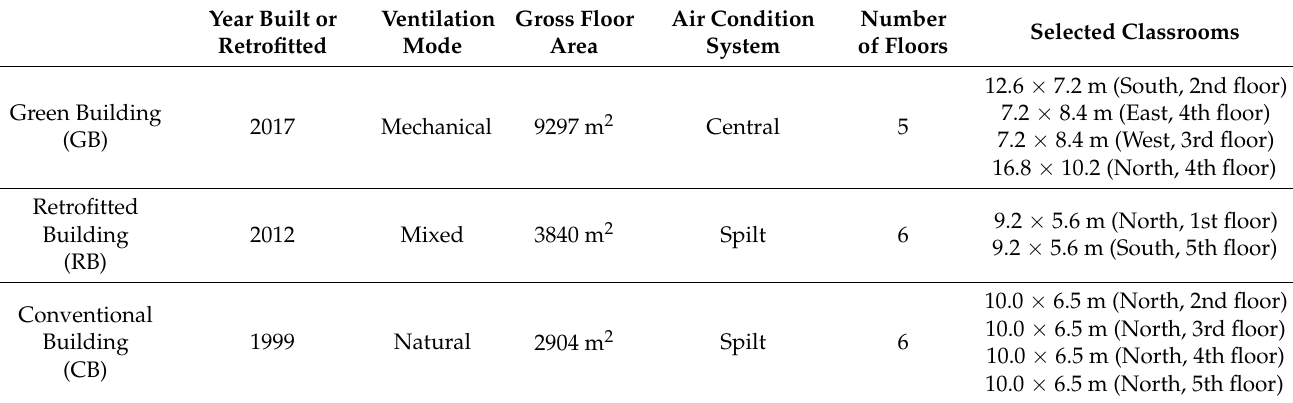
Table 1. Characteristics of the selected teaching buildings.